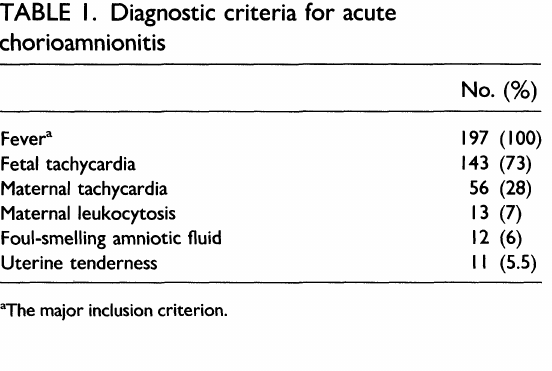
TABLE I. Diagnostic criteria for acute chorioamnionitis